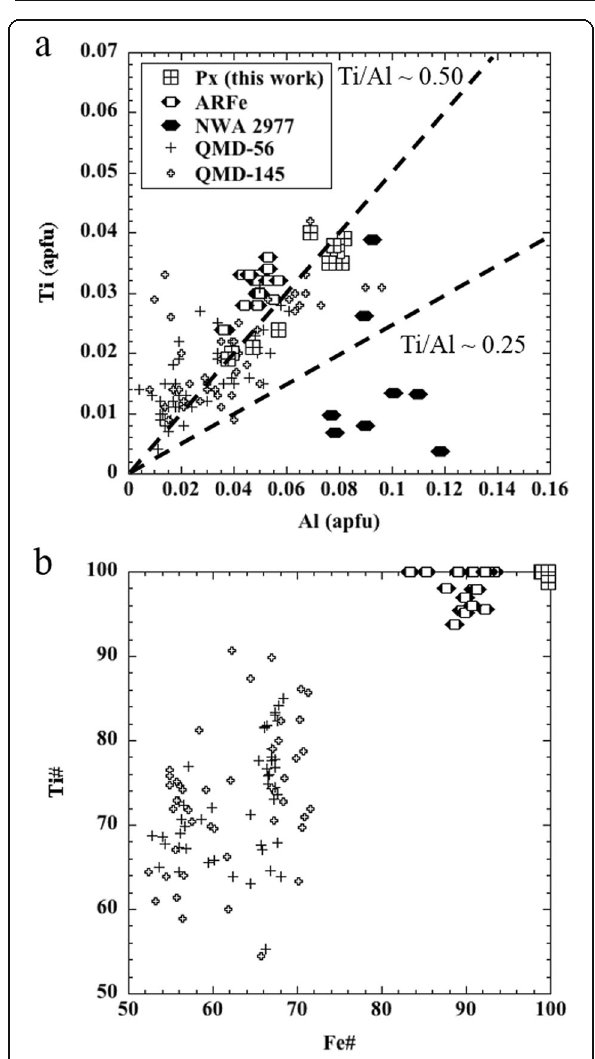
Fig. 6 a Al versus Ti and b Fe# versus Ti# in pyroxenes from the silicic clast (this work). Compositions of ARFe clasts in NWA 773 (Fagan et al. 2014), NWA 2977 OG (Nagaoka et al. 2015), and 15405 QMD (56, 145) (Fagan et al. 2014) are also